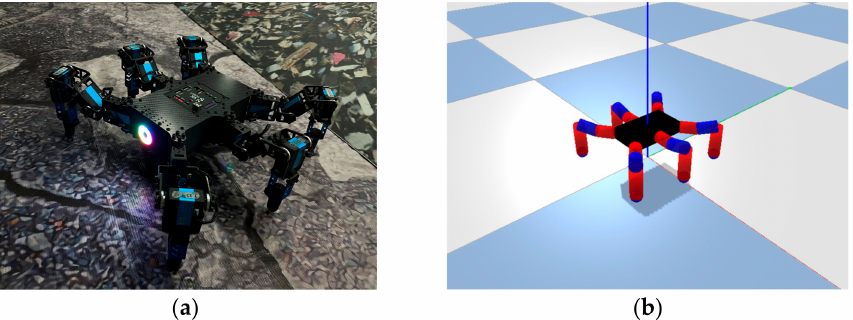
Figure 1. ( a ) Physical prototype of the hexapod robot VkHex; ( b ) simulated prototype of the VkHex in PyBullet.